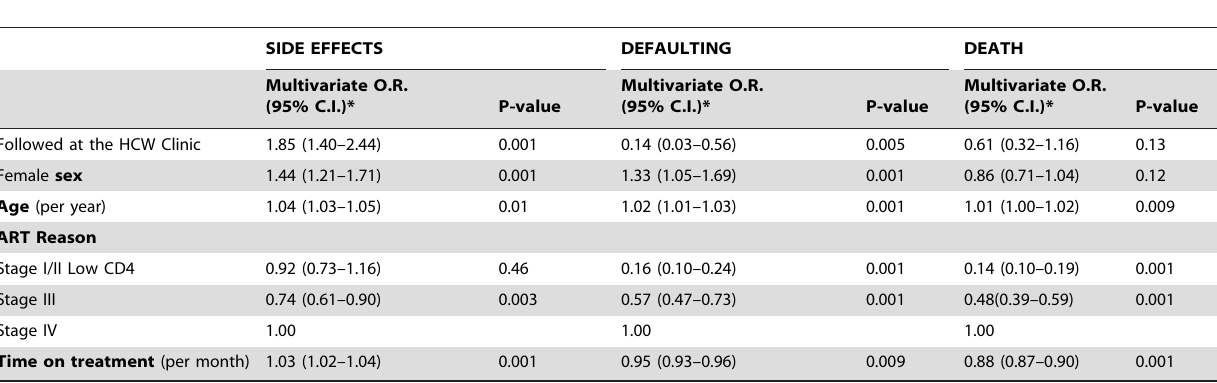
Table 3. Factors associated with the occurrence of side effects, defaulting and death among patients being followed at the Health Care Worker clinic and general clinic in Zomba Central